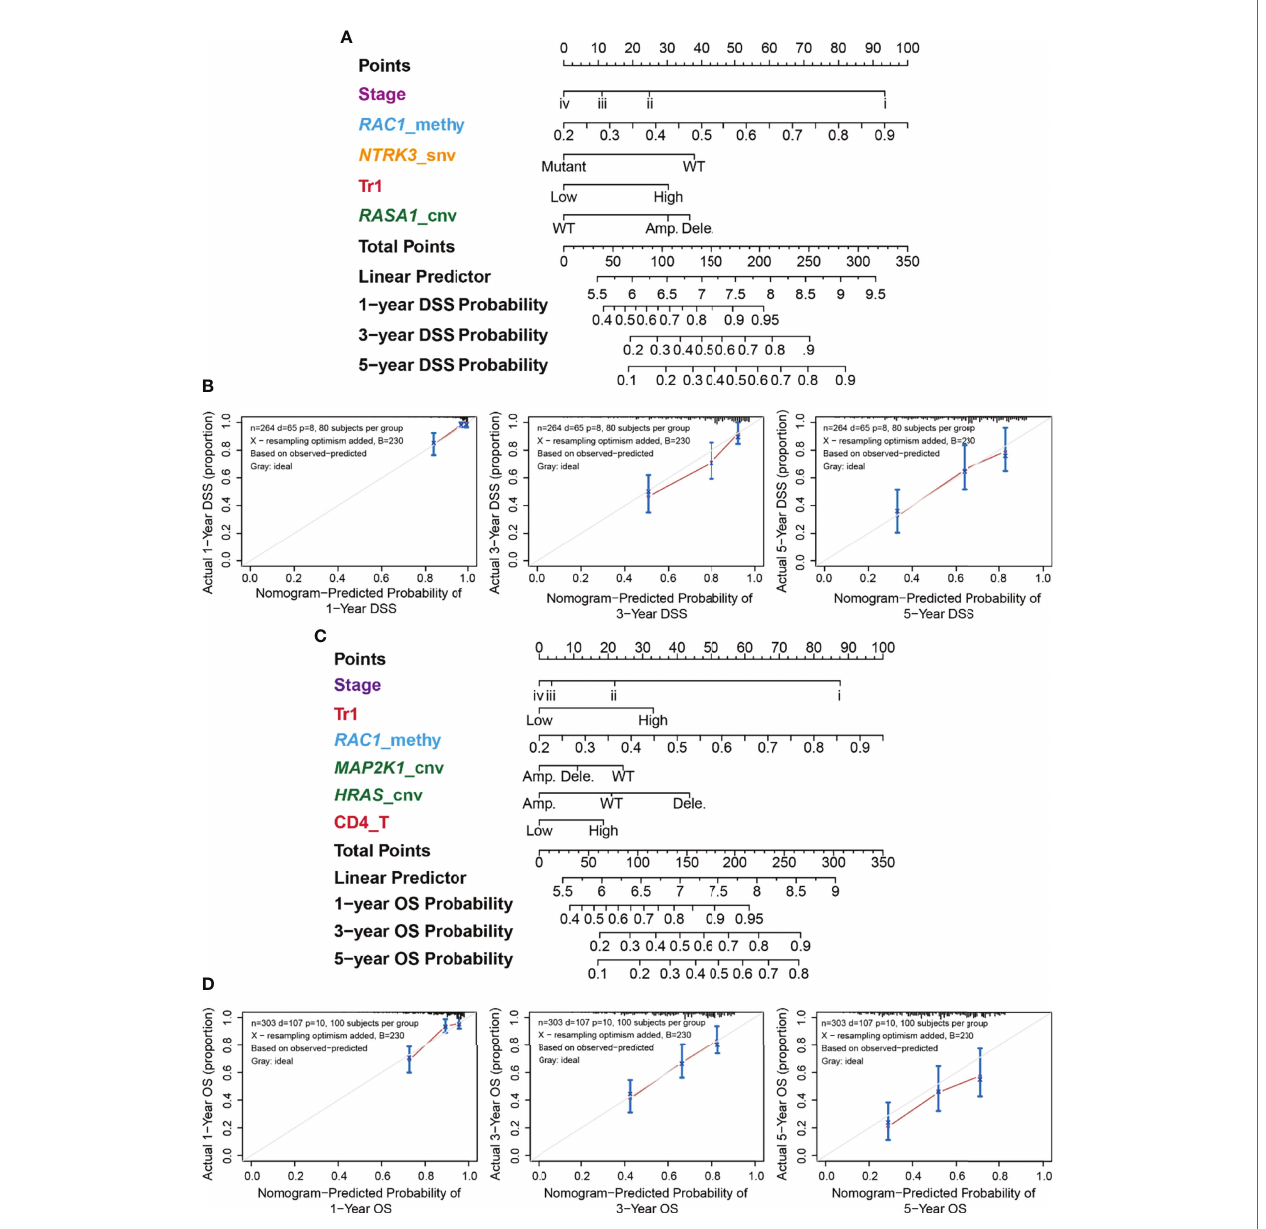
FIGURE 6 | Nomogram for the DSS of LUAD and its performance. (A) Predictive nomogram of DSS for LUAD. The row “ Points ” correspond to each signature. For example, stage iv got 0 points, while stage i got nearly 90 points. The sum of signatures ’ points is the row “ Total Points, ” which correspond to survival probability. (B) Correspondence between actual and ideal nomogram predictions for 1-, 3-, and 5-year DSS. Nomogram-predicted probability of survival is plotted on the x-axis; actual survival is plotted on the y-axis. (C) Predictive nomogram of OS for LUAD. (D) Correspondence between actual and ideal nomogram predictions for 1-, 3-, and 5-year